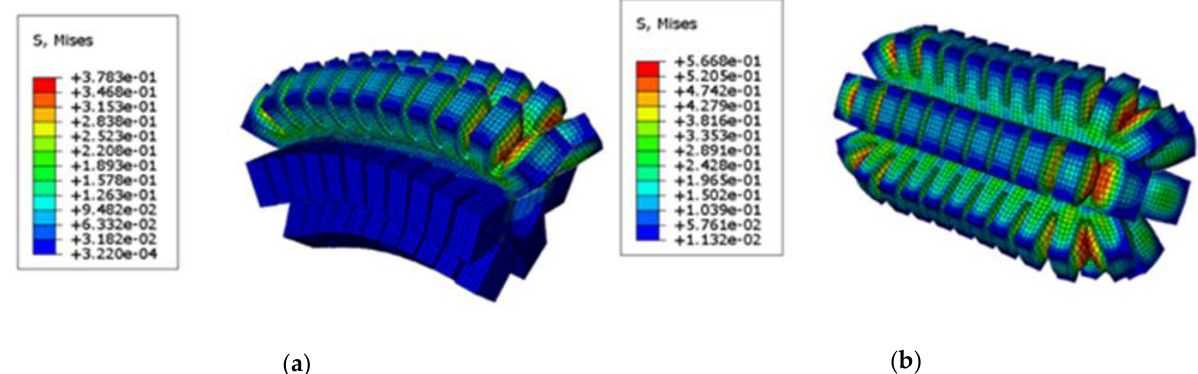
Figure 7. Deformation analysis diagram of hexagonal prism soft-bodied bionic actuator. ( a ) Bending deformation of hexagonal prism soft-bodied bionic actuator. ( b ) Expansion deformation of hexagonal prism soft-bodied bionic actuator.